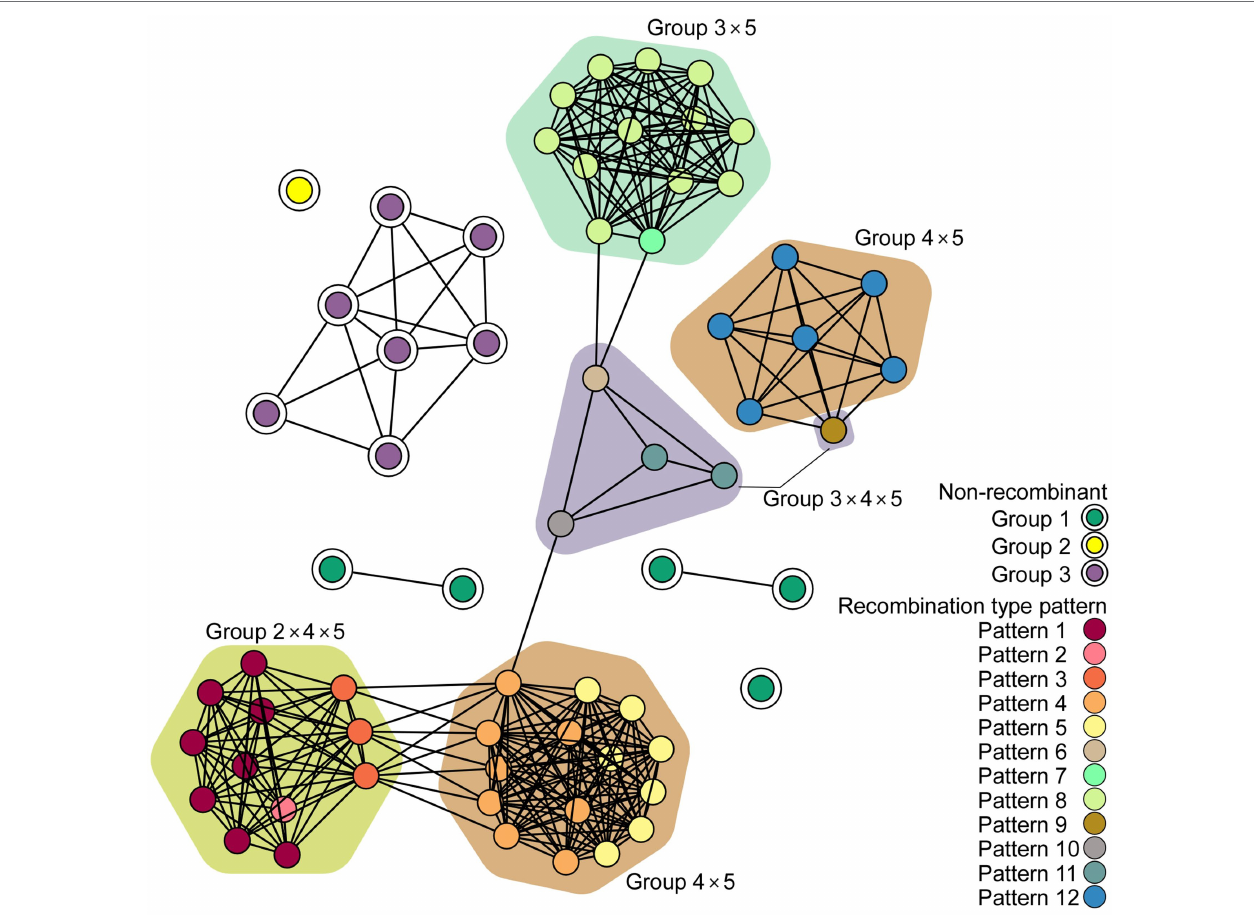
FIGURE 3 | Network diagram of scallion mosaic virus (ScaMV) genomic sequences. Each node represents a ScaMV genome, and each edge indicates that respective node has a pairwise k -mer distance under the threshold (0.91). Double circled nodes represent non-recombinant ScaMV genomes and colored by their phylogenetic group, whereas non-circled nodes represent recombinant ScaMV genomes. The polygon color represents the combination of phylogenetic group in their parental sequences in each